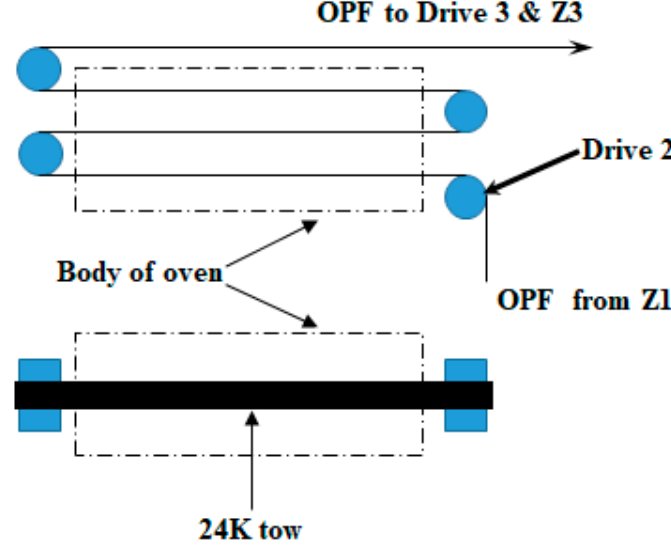
Figure 1. Schematic diagram of zone 2 of the stabilization oven studied.